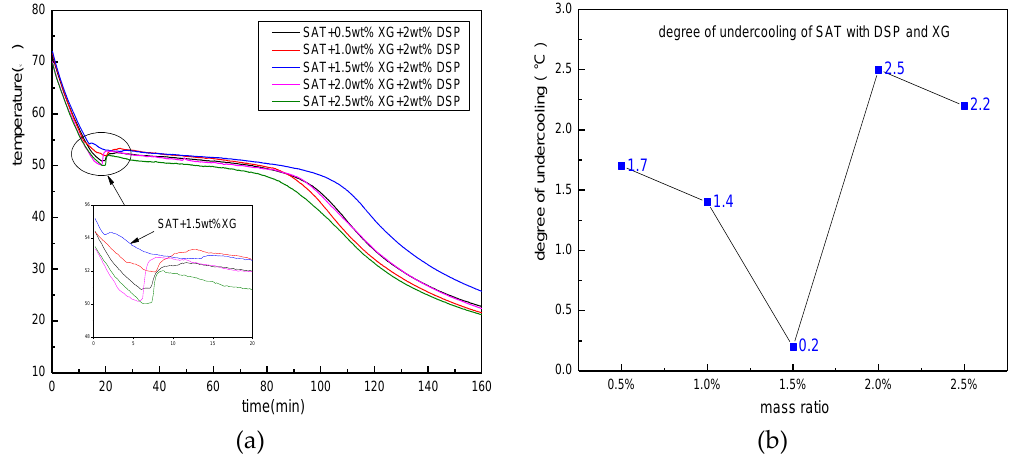
Figure 7. The nucleation effect of thickeners on matrix material. ( a ) the discharging curves of SAT with XG and DSP; ( b ) distribution of degree of undercooling.